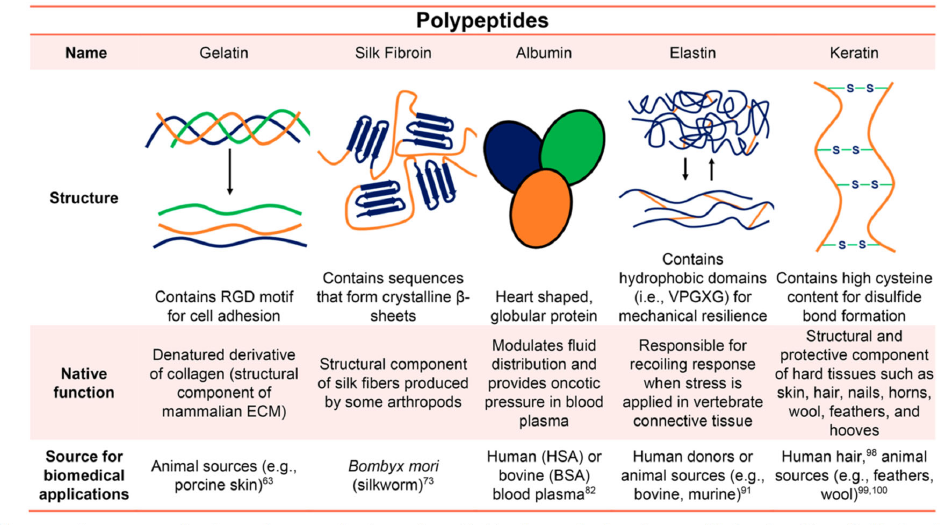
Figure 6. Polypeptide-Based Biopolymers a . Reprinted with permission from Ref. [98], Copyright 2015, American Chemical Society.